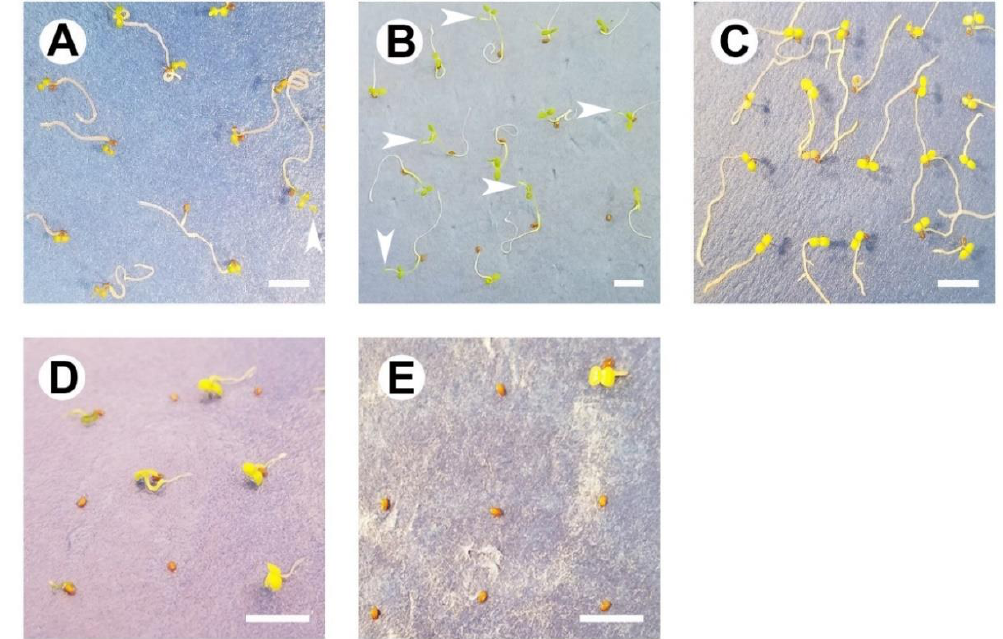
Figure 6. Linum arenicola seedlings after a 28-day germination test. Seeds were exposed to ( A ) 0, ( B ) 1, ( C ) 4, ( D ) 6, or ( E ) 10 parts per thousand NaCl. Scale bars = 5 mm. Image magnification equals ( A ) 5 × , ( B ) 2 × , ( C ) 5 × , ( D ) 10 × , and ( E ) 10 × . Arrowheads denote shoots with leaves.